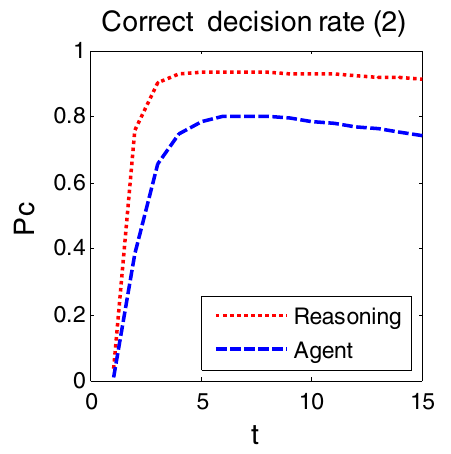
Figure 9. Correct decision rate in case 2.